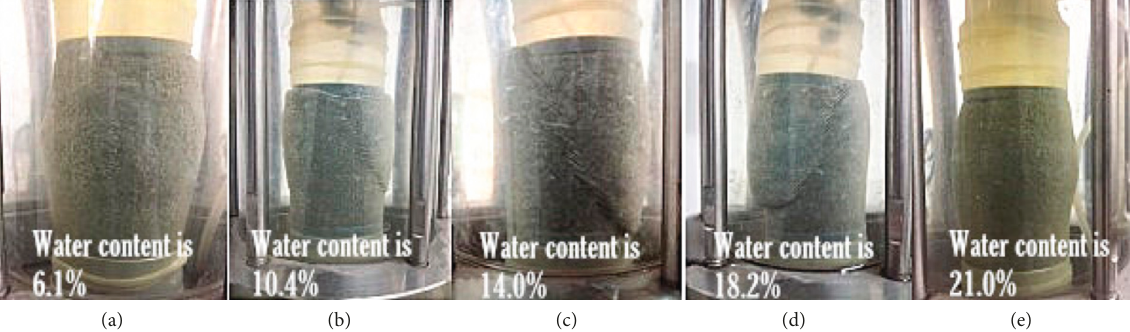
Figure 5: The shape of the samples with different water contents after failure. Water content: (a) 6.1%, (b) 10.4%, (c)14.0%, (d) 18.2%, and (e)